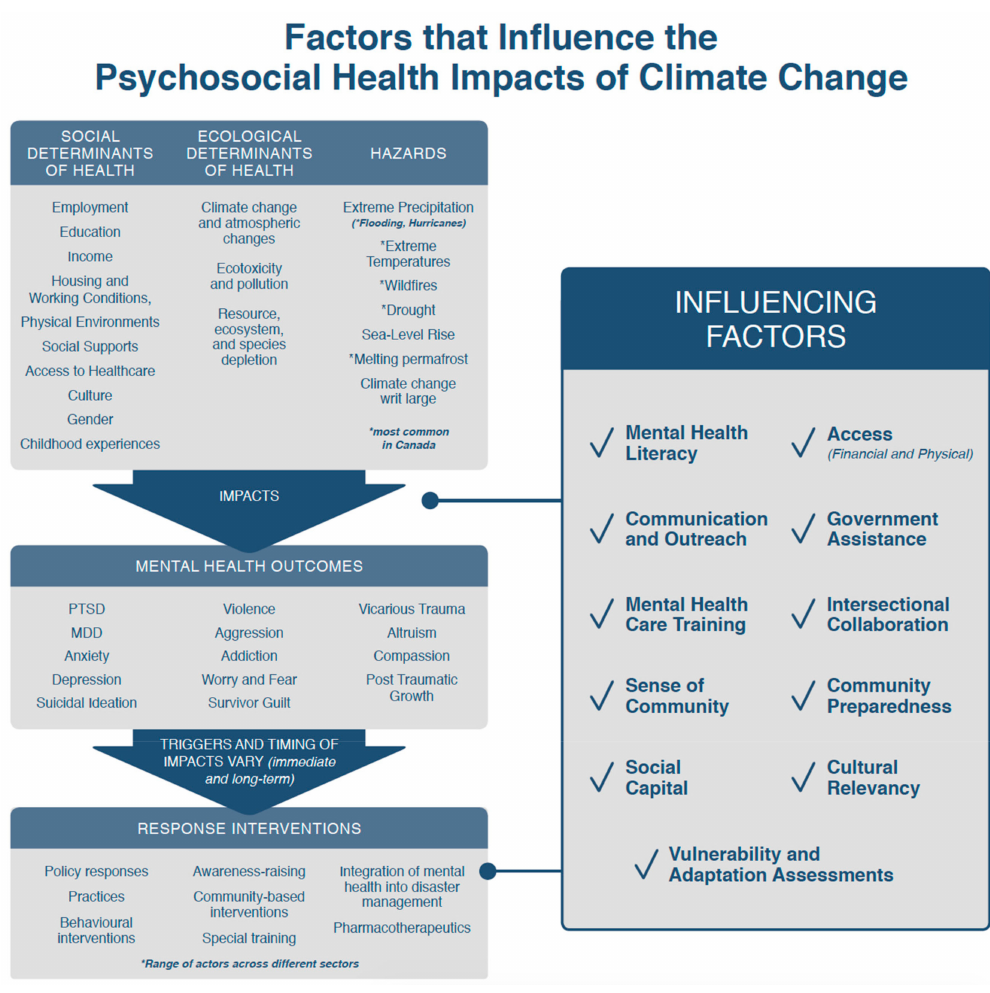
Figure 1. Factors that influence the psychosocial health impacts of climate change. A framework showing the mental health consequences of climate change and how these consequences are mediated by the social and ecological determinants of health, response interventions, and factors that influence psychosocial adaptation when they are in place or when absent act as barriers to psychosocial